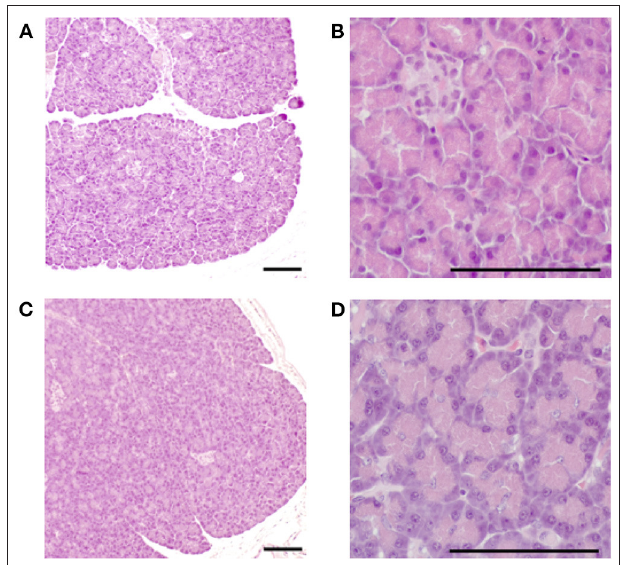
FIGURE 4 | Histopathological image of the pancreas in the pimobendan group. Eosinophilic zymogen granules were observed in the pancreatic acinar cell both before initiating rapid ventricular pacing (baseline) and at 4 weeks after initiating rapid ventricular pacing (4 weeks). (A,B) baseline. (C,D) 4 weeks. Bars = 100 µ m.